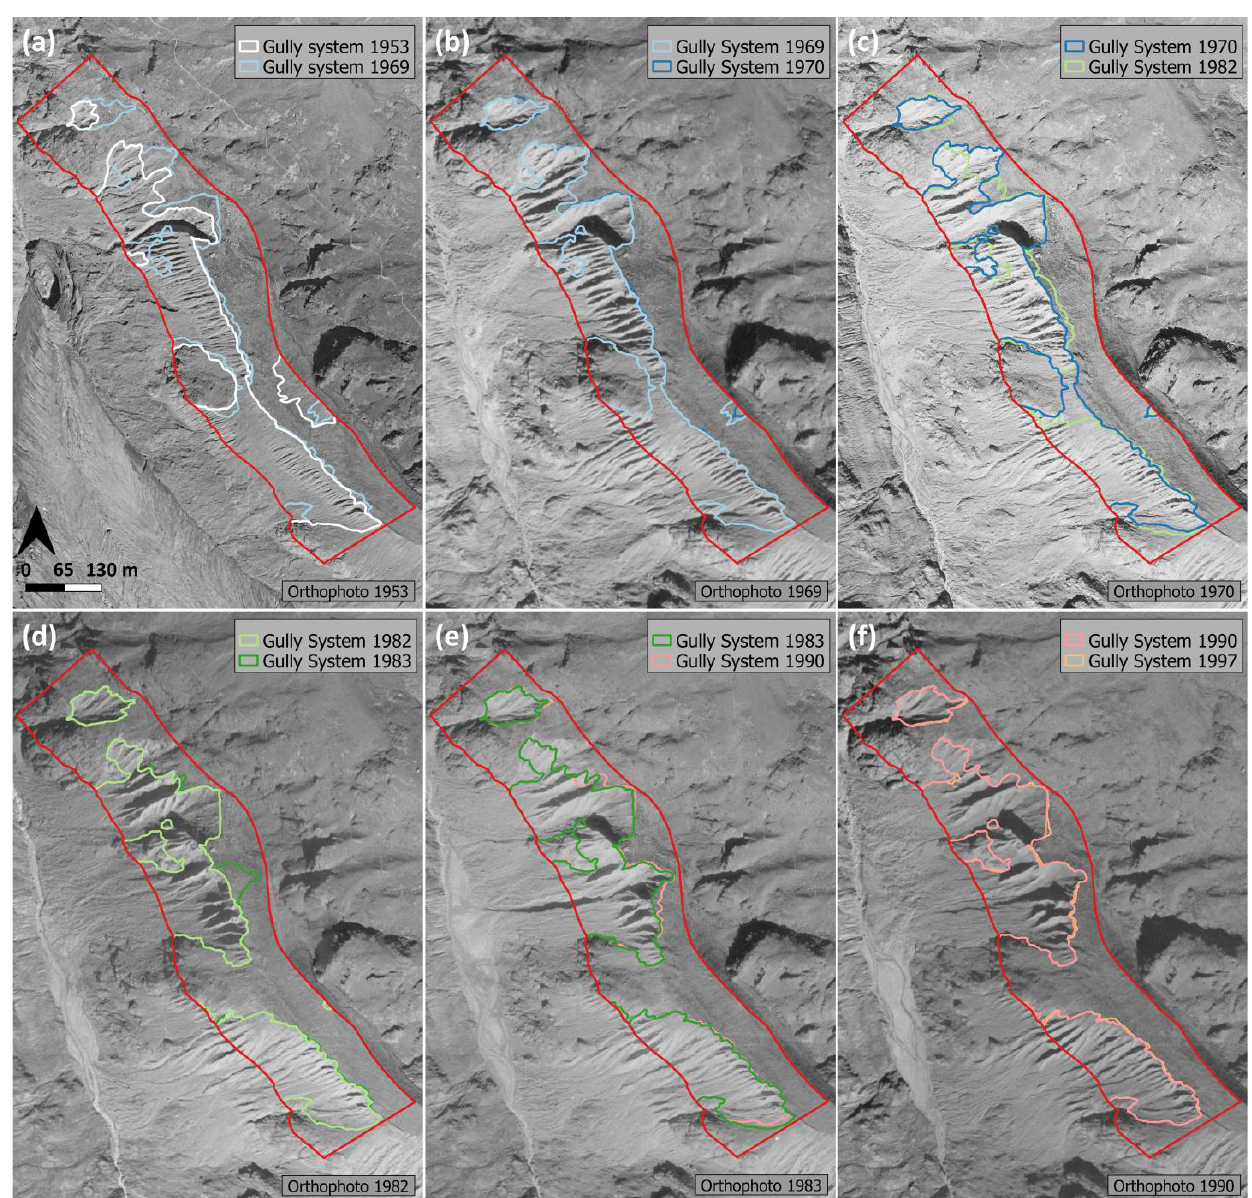
Figure A3. Continued mapping of the different surface types (morphodynamic mapping) using georeferenced orthophotos based on overlapping area-wide aerial photographs from 1953 to 1990 ( a – f ). The red line indicates the area of interest.